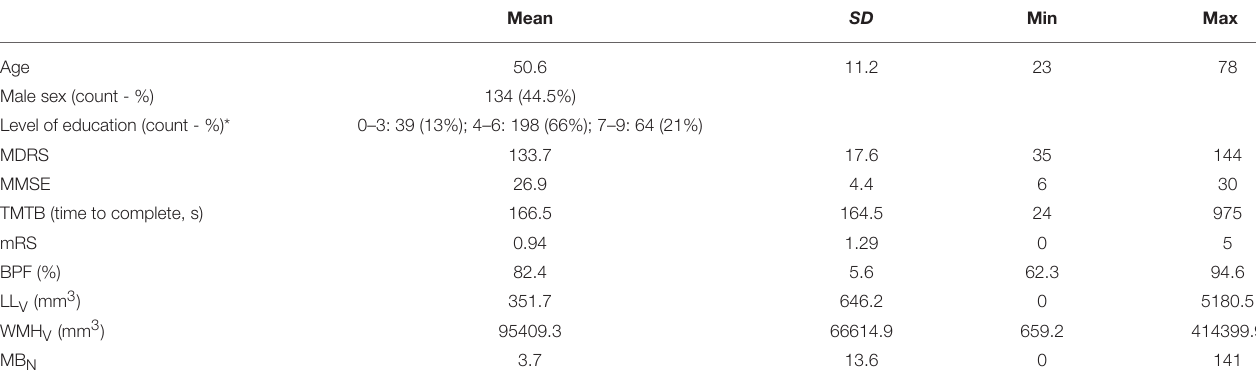
TABLE 1 | Clinical and MRI data of the 301